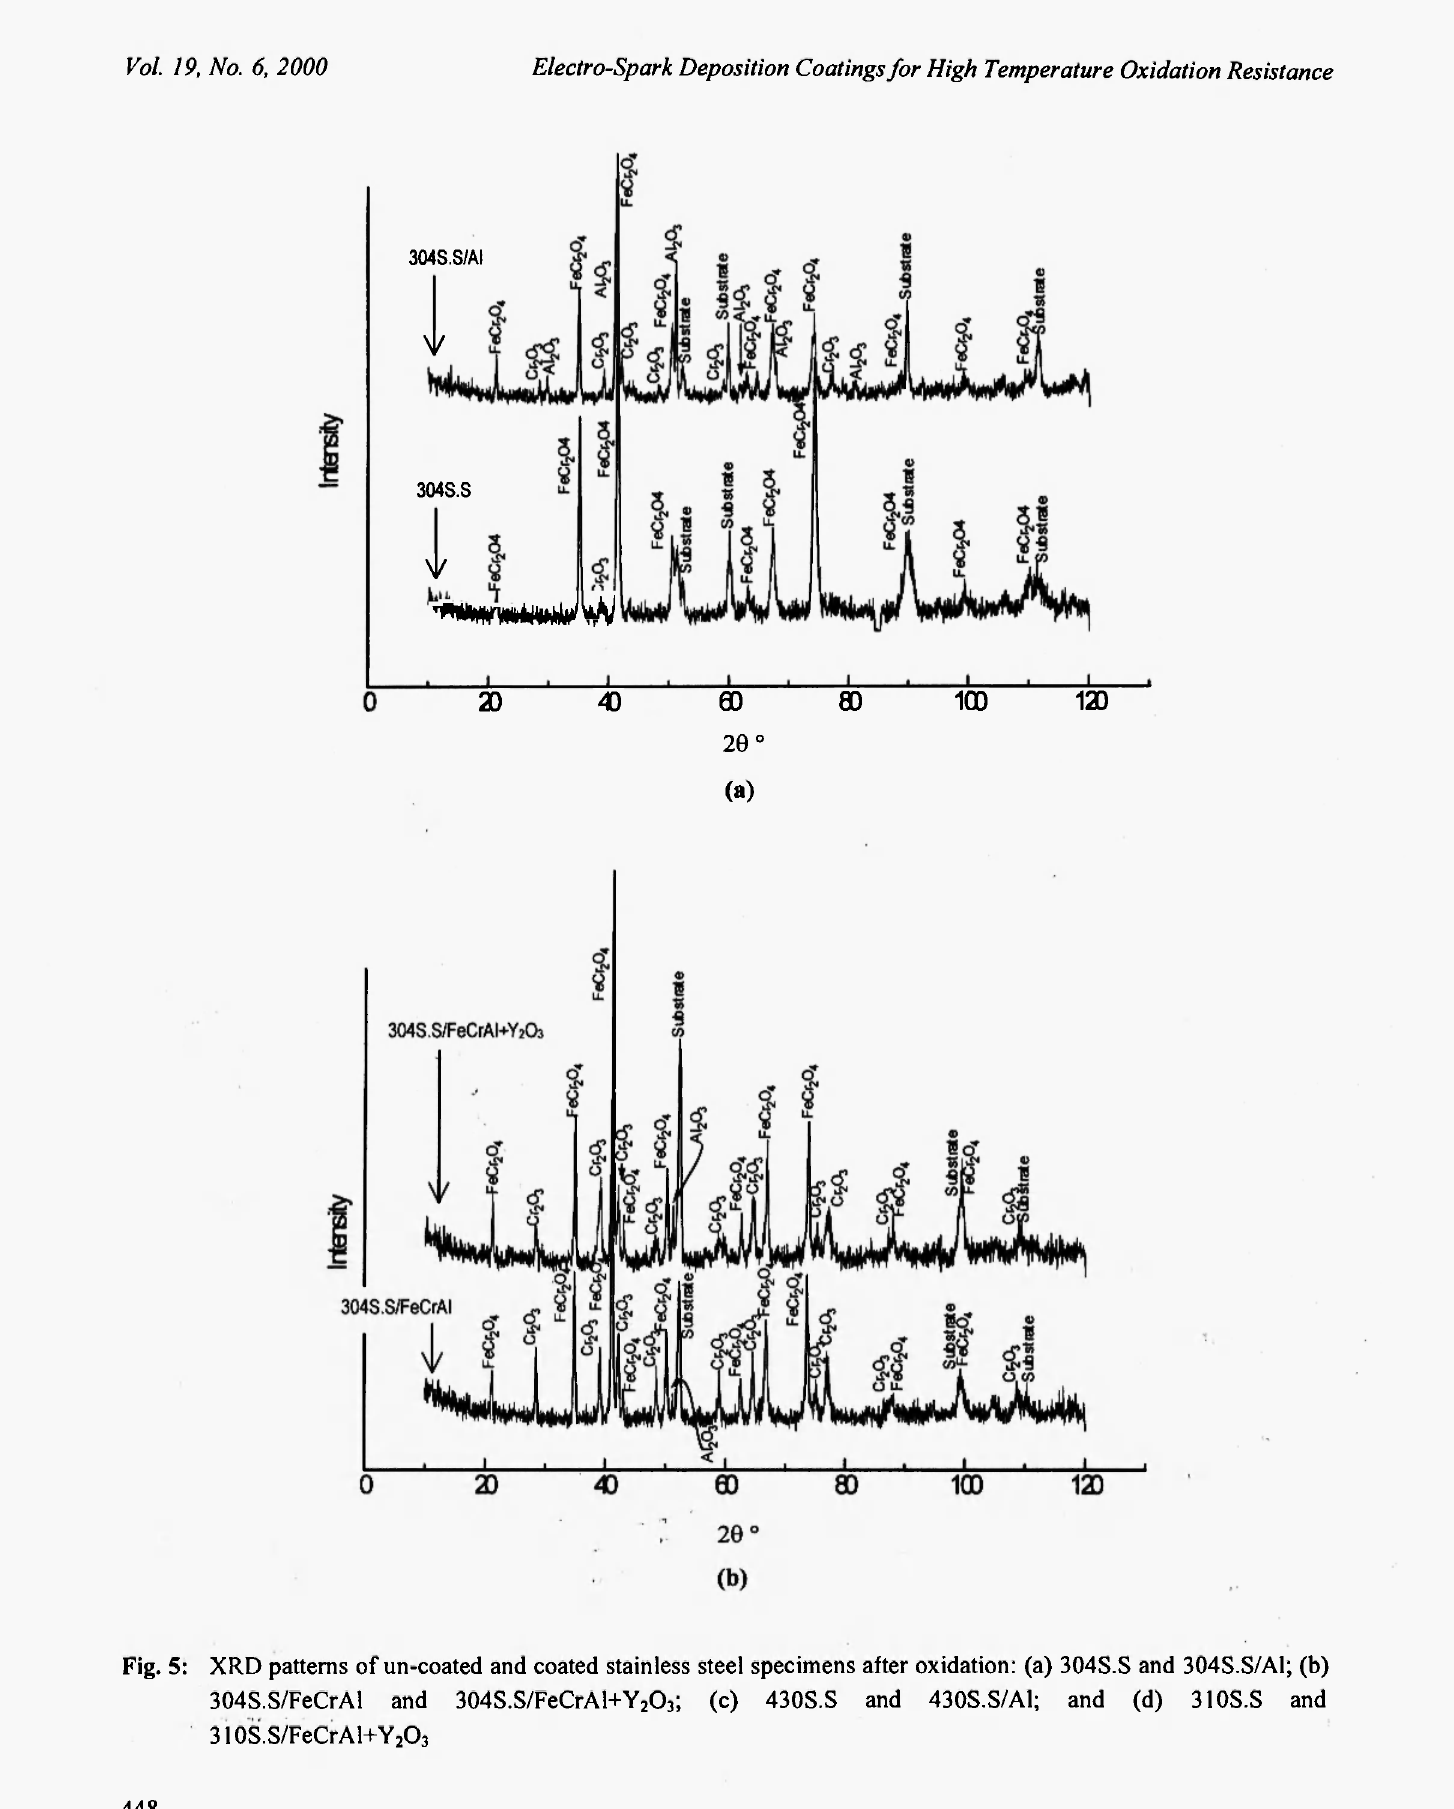
Fig. 5: XRD patterns of un-coated and coated stainless steel specimens after oxidation: (a) 304S.S and 304S.S/A1; (b) 304S.S/FeCrAl and 304S.S/FeCrAl+Y 2 0 3 ; (c) 430S.S and 430S.S/A1; and (d) 310S.S